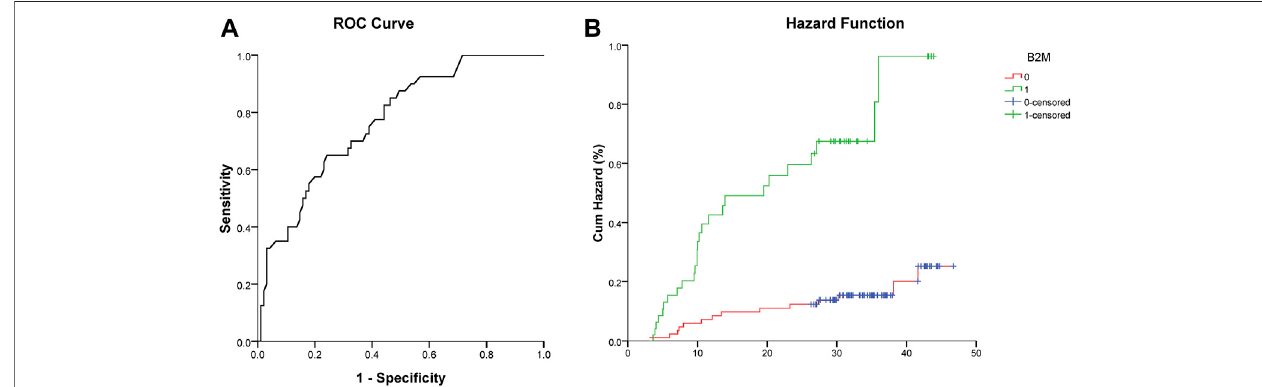
FIGURE2|(A) ROCcurveanalysisshowedapredictiveserumlevelof β 2Mforstrokerecurrence. (B) Cumulativehazard(%)ofrecurrentstrokebetweenthelow(0, β 2M ≤ 2.31 mg/L) and high (1, β 2M > 2.31 mg/L) β 2M groups (Log-rank test, χ 2 = 23.840, p < 0.001).